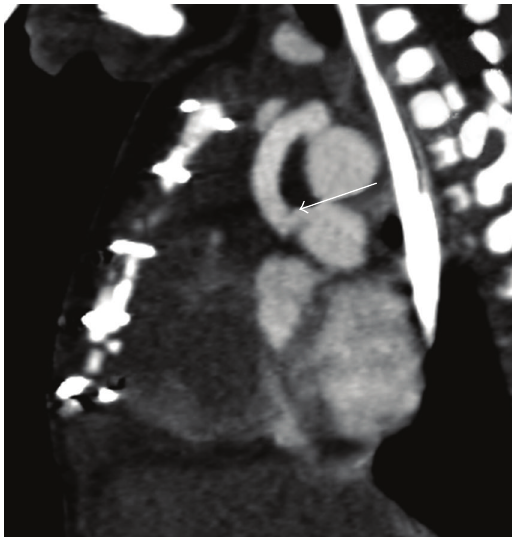
Figure 1: CT angiography (sagittal view) demonstrating a narrow- ing of the modified BT shunt at the point of anastamosis with the pulmonary artery.